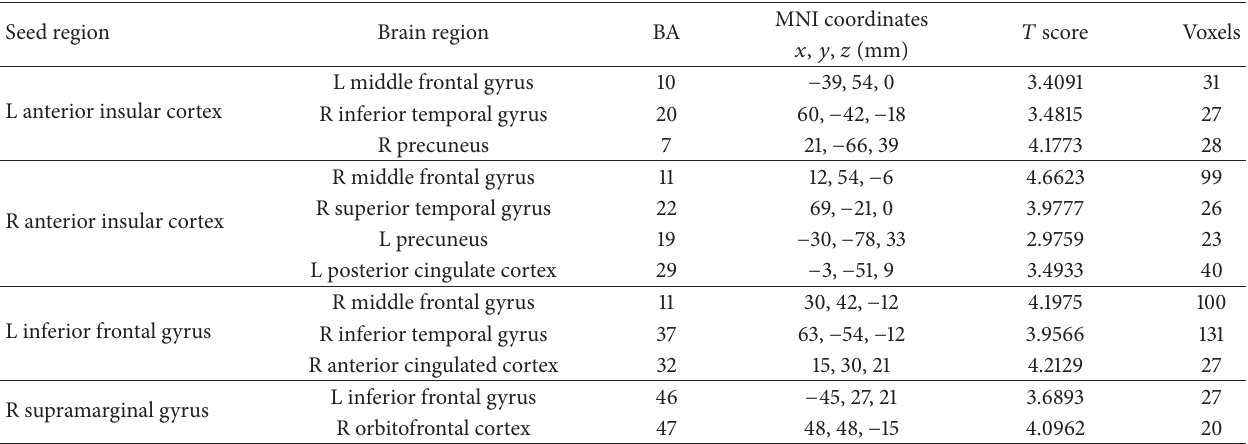
Table 4: Abnormal functional connectivity of four seed regions in tinnitus patients compared with healthy controls.